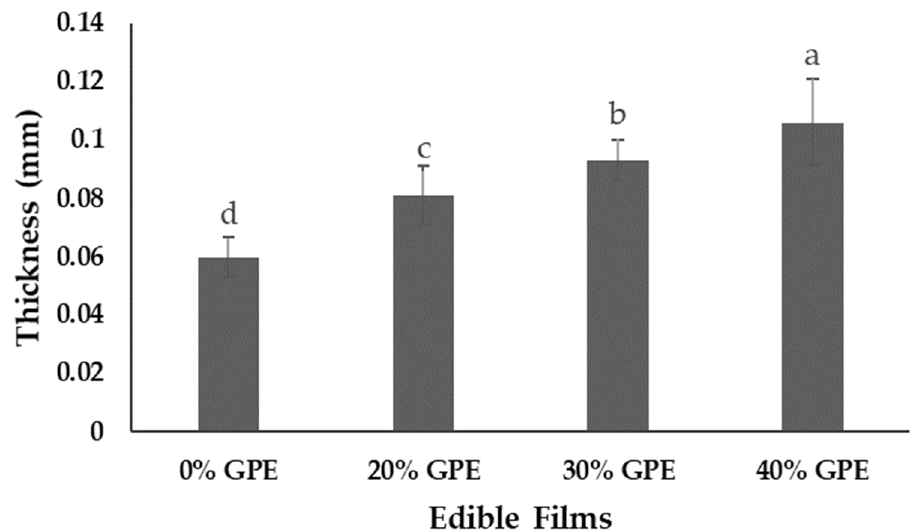
Figure 2. Thickness (mm) of edible films of arrowroot ( Maranta arundinacea Linn.) starch with 0, 20, 30, and 40% of grape pomace extract (GPE). Values with the same letter in the columns do not statistically differ by Tukey’s test ( p < 0.05).